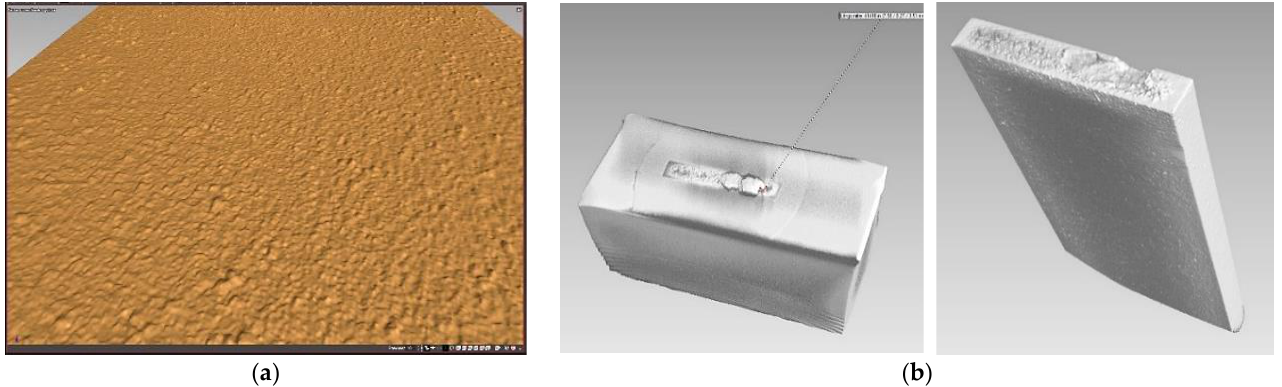
Figure 8. ( a ) Representative image of surface quality archived by laser melting of CoCr powder (SLM parameters are detailed in Section 2.2); ( b ) 3D reconstructions developed using CT images after mechanical testing.